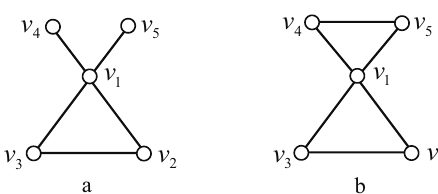
Figure 4. Graphs of d ( G ) = 2, n ( G ) = 5 and c ( G ) = 3. For a , v 4 and v 5 are nonadjacent; for b , v 4 and v 5 are adjacent.